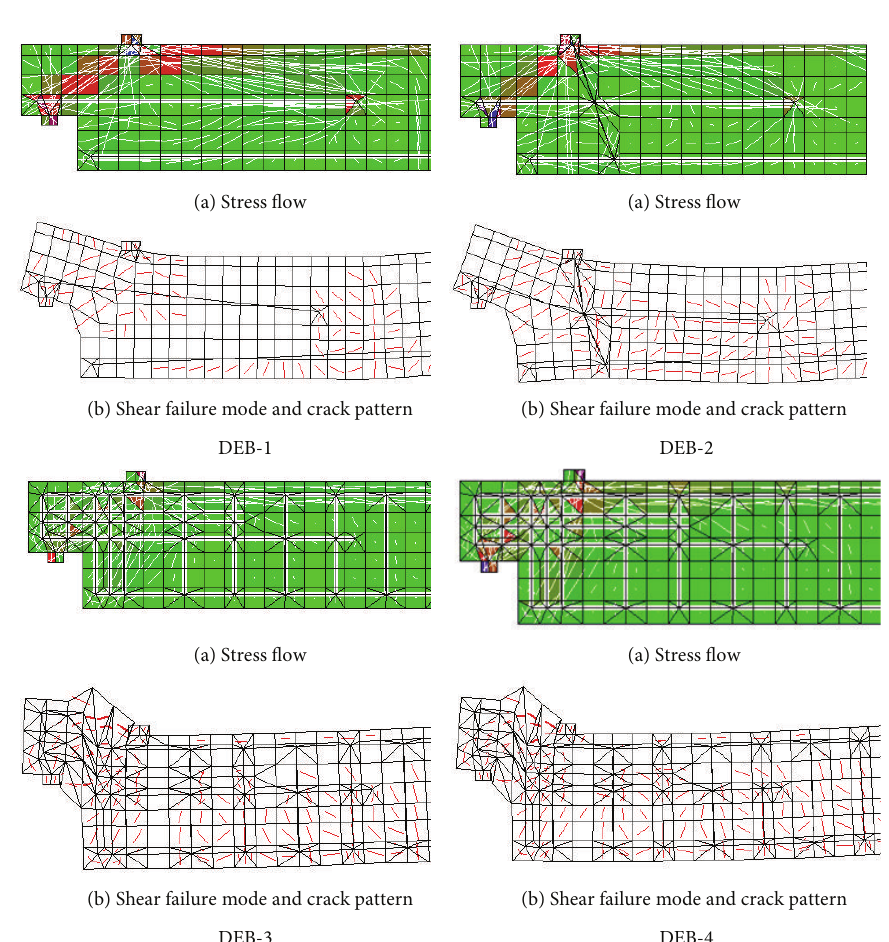
Figure 11: The high stress flow and crack pattern based on Vec2